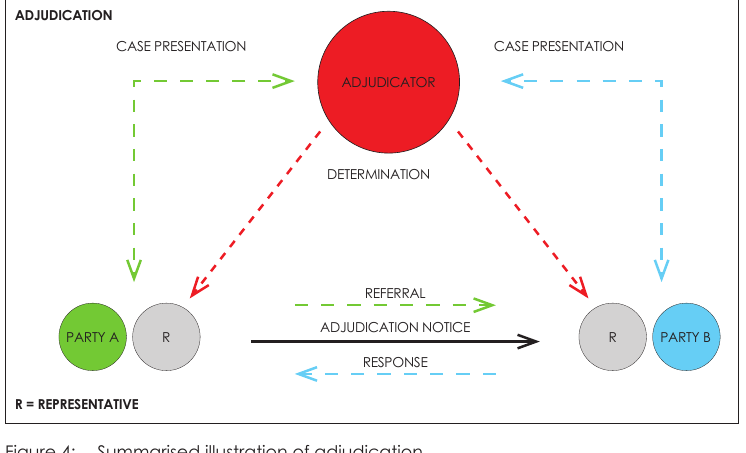
Figure 4: Summarised illustration of